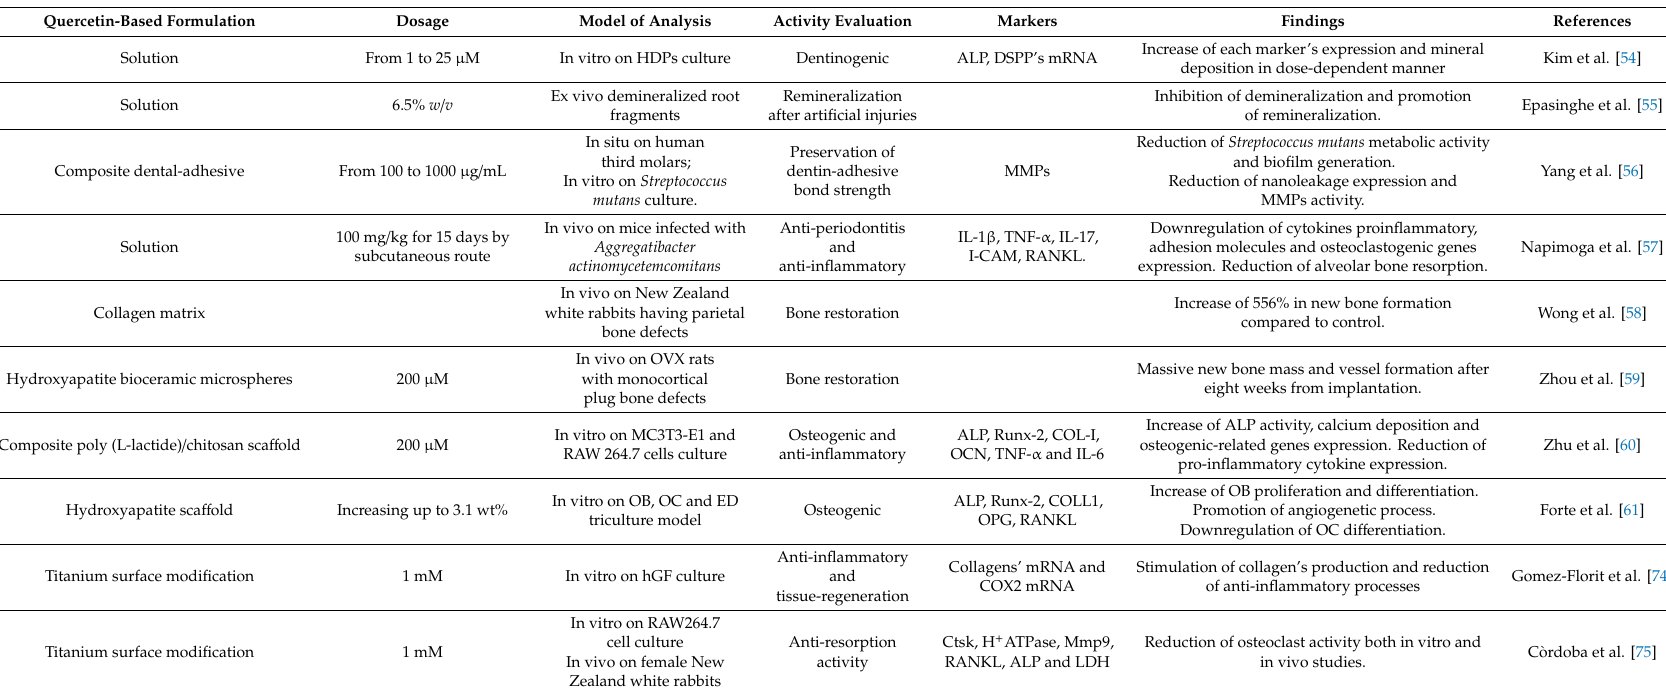
Table 2. Summary of both the in vitro and in vivo QRC-based formulations’ activities on periodontal